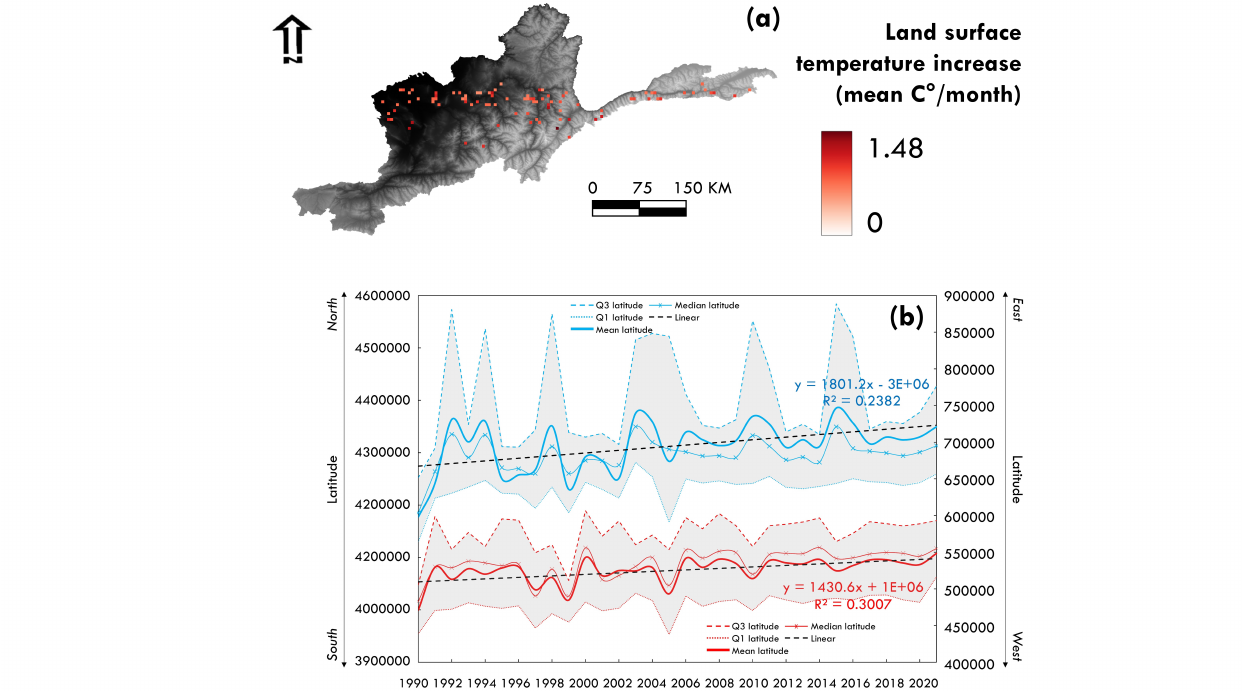
Figure 11. (a) Map of areas with significant increases in monthly land surface temperatures in the Amu Panj basin based on MOD11C3 products from 2000 to 2021. (b) Geographical shift of avalanche deposits: mean longitude and latitude of avalanche deposits each year since 1990 show evidence of a movement to the northeast due to increasing winter temperature in mountainous